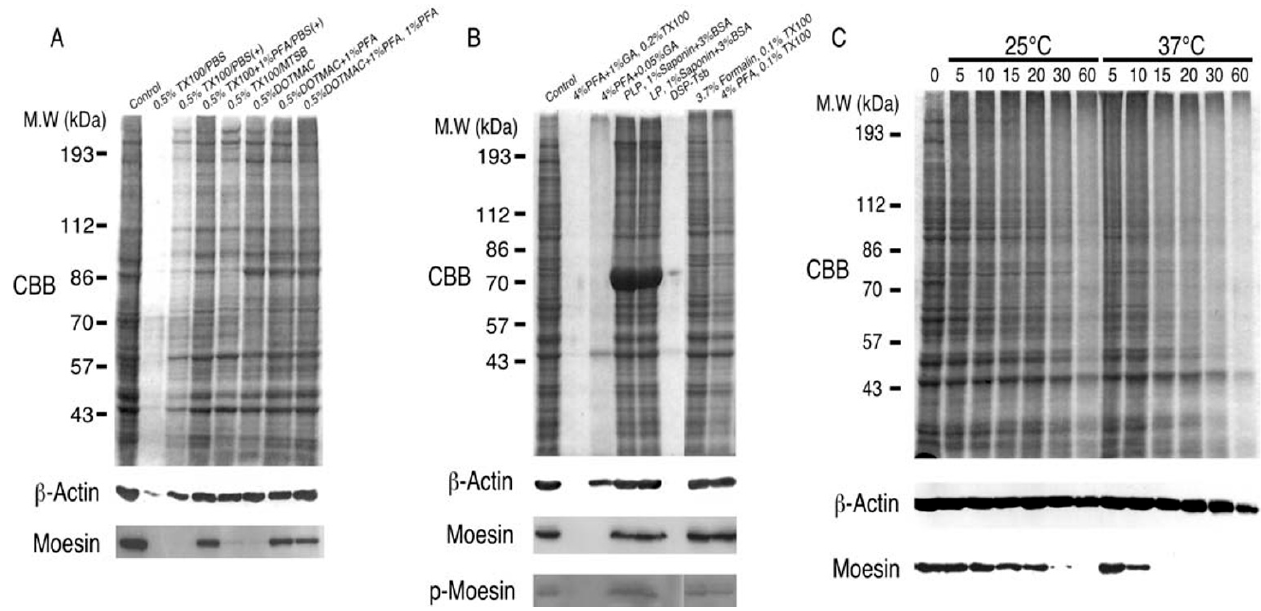
Figure 6 SDS-polyacrylamide gel electrophoresis of extracted polypeptides from NIH3T3 cells after fixation and/or per- meabilization. Subconfluent cultures of cells were rinsed with PBS(+), fixed and/or extracted as indicated. After rinsing with PBS, the material remaining on the culture dish was extracted with SDS sample buffer. The dissolved and undissolved material was collected and heated at 95 ° C for 10 min and resolved by SDS-PAGE on a 9% polyacrylamide gel. Polypeptides were stained with Coomassie Brilliant blue (CBB). β -Actin, moesin, and threonine558-phospho-moesin were detected by immunob- lot analysis. (A) Cells were extracted with the extraction buffer as indicated in the figure for 5 min at room temperature. In the last lane to the right, cells were fixed with 1% PFA in PBS for 20 min at 4 ° C after extraction. (B) Cells were fixed and/or extracted with the fixative indicated in the figure as shown in Table 1 except that 3.7% formalin was used instead of 3.7% for- maldehyde in lane 7. (C) Cells were fixed with 4% PFA in PBS(+) for the indicated time period (min) at 25 ° C or 37 ° C, rinsed with PBS, and then extracted with SDS sample buffer. Note that moesin is more readily irreversibly crosslinked than actin. Other polypeptides appeared to be same as